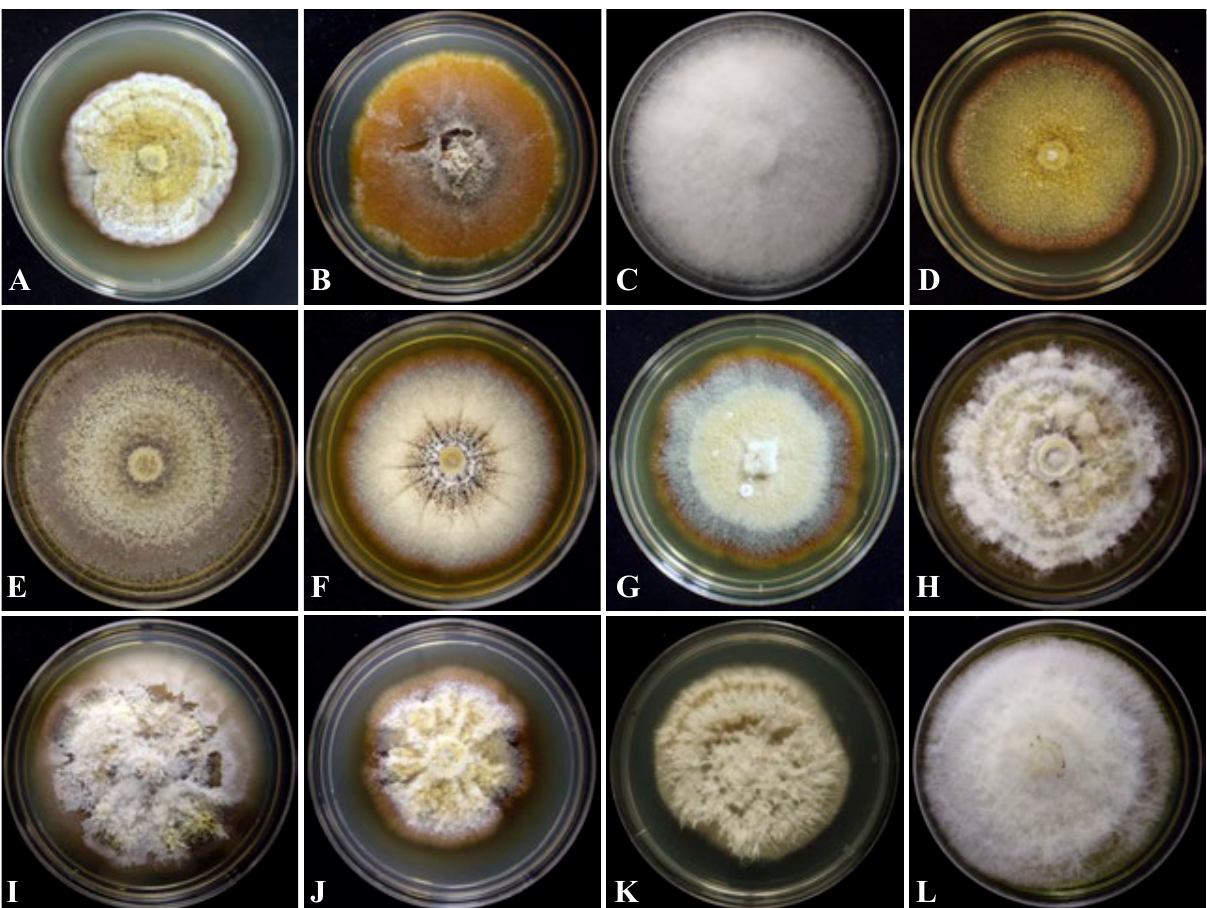
Figure 3. Colonies of black-foot pathogens grown on PDA. A, “ Cylindrocarpon ” destructans (CBS 301.93); B, “ C. ” paucisep- tatum ; C, “ C. ” obtusisporum ; D, Ilyonectria alcacerensis ; E, I. liriodendri ; F, I. novozelandica ; G, I. macrodidyma ; H, I. torresensis ; I, Campylocarpon fasciculare ; J, Campyl. pseudofasciculare ; K, Cylindrocladiella parva ; L, Cyl. peruviana